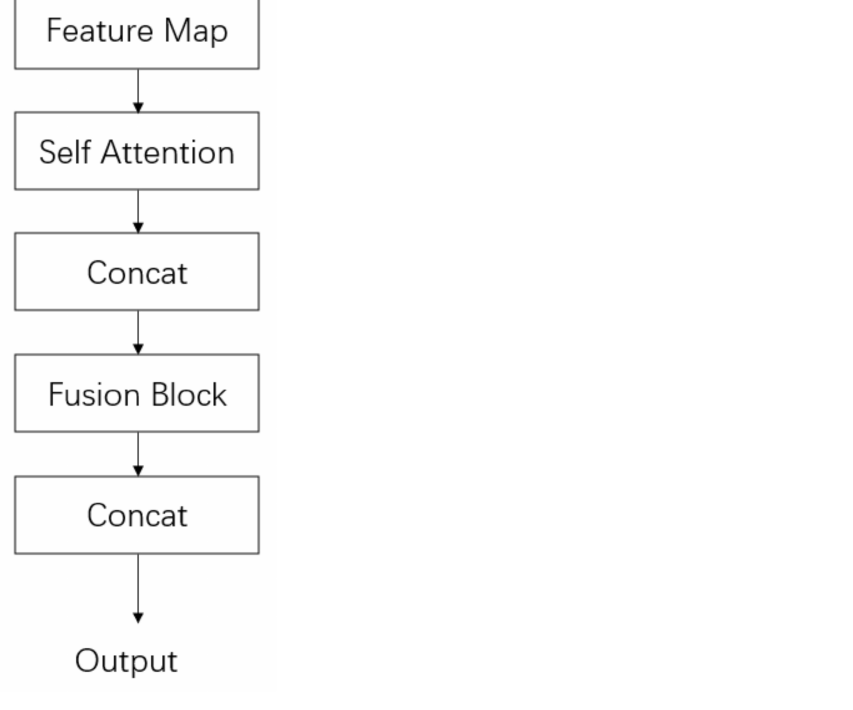
Figure 6. Schematic diagram of the feature fusion module framework.